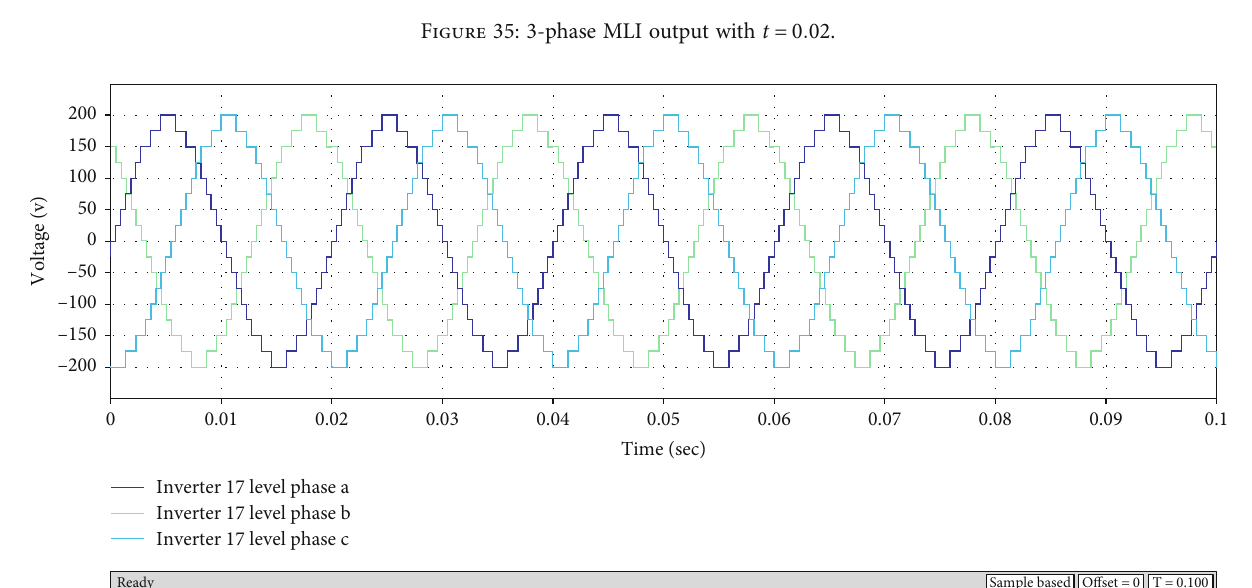
Figure 36: 3-phase MLI output with t = 0 : 1